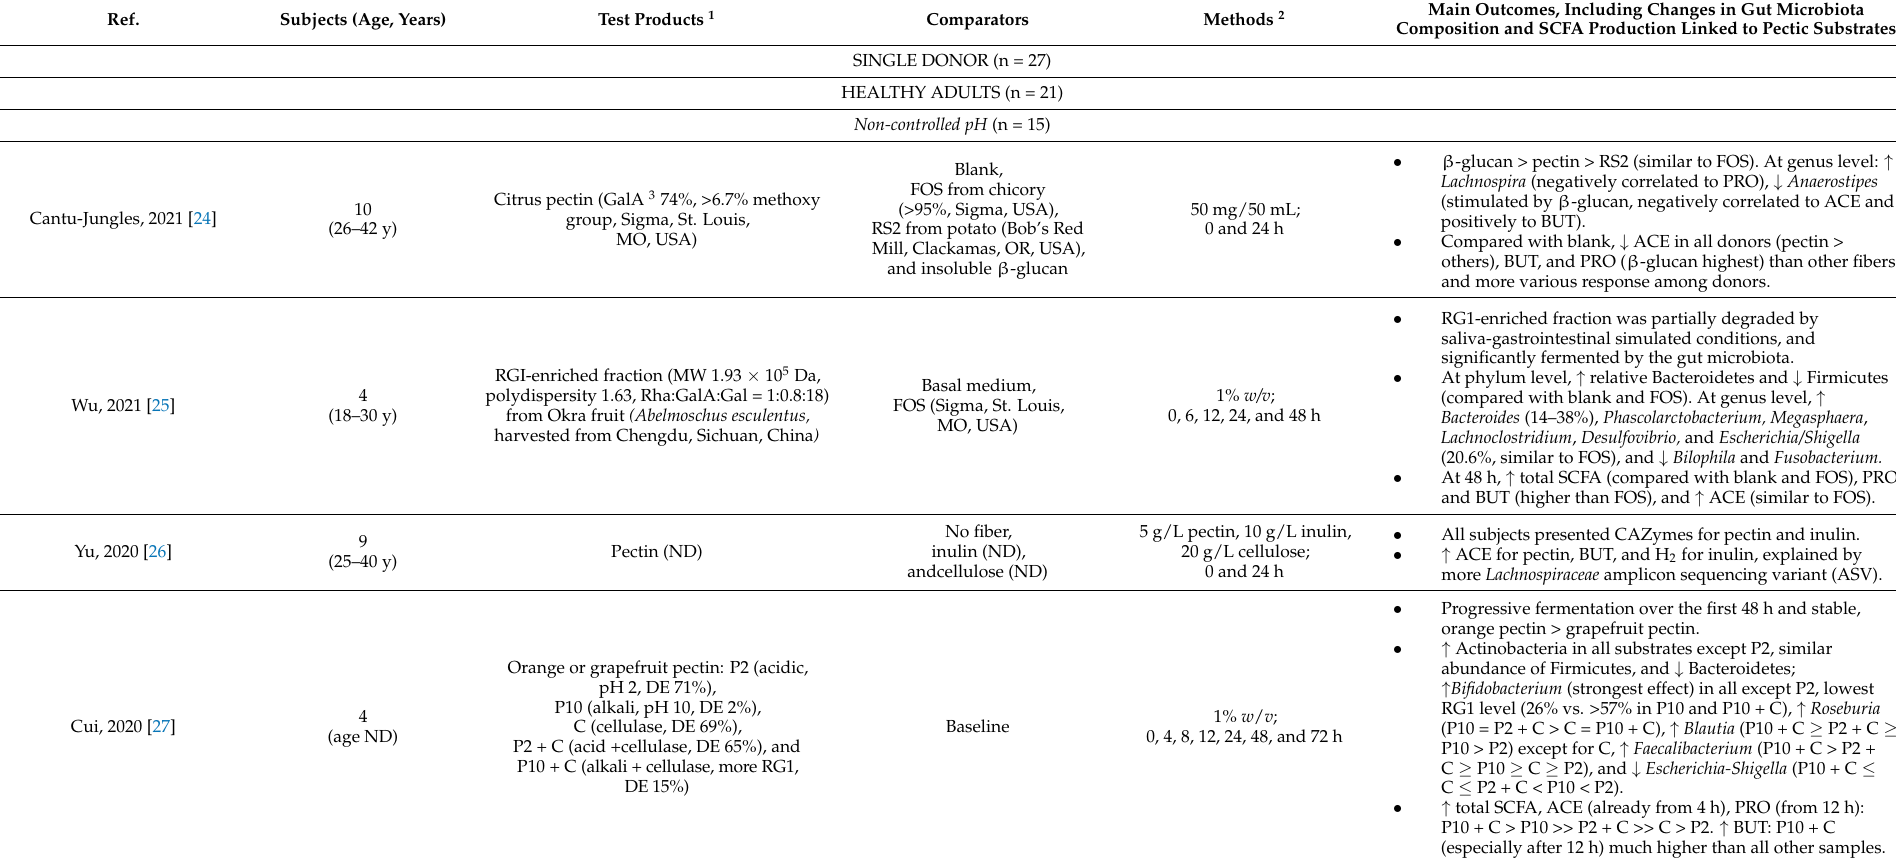
Table 2. Batch fermentation studies with human gut microbiota; (n = 31; 27 single donor and 4 with pooled samples (healthy vs. specific population).